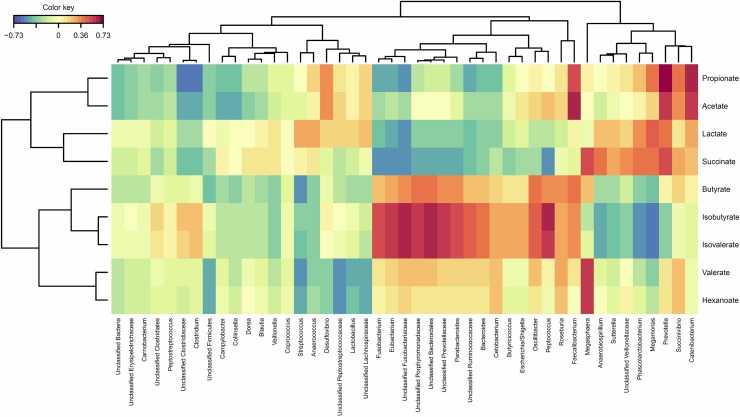
Canonical correlation clustered image map illustrating associations between organic acid concentrations and bacterial genus.Faecal organic acid concentrations (umol/g DM faeces) from faeces of adult domestic cats fed three experimental diets (Kibble, Raw+Fibre and Raw). Correlation cut off was |0.6|, greater that 0.6 considered a highly positive correlation (increasing red intensity) and lower than -0.6 considered a highly negative correlation (increasing blue intensity).